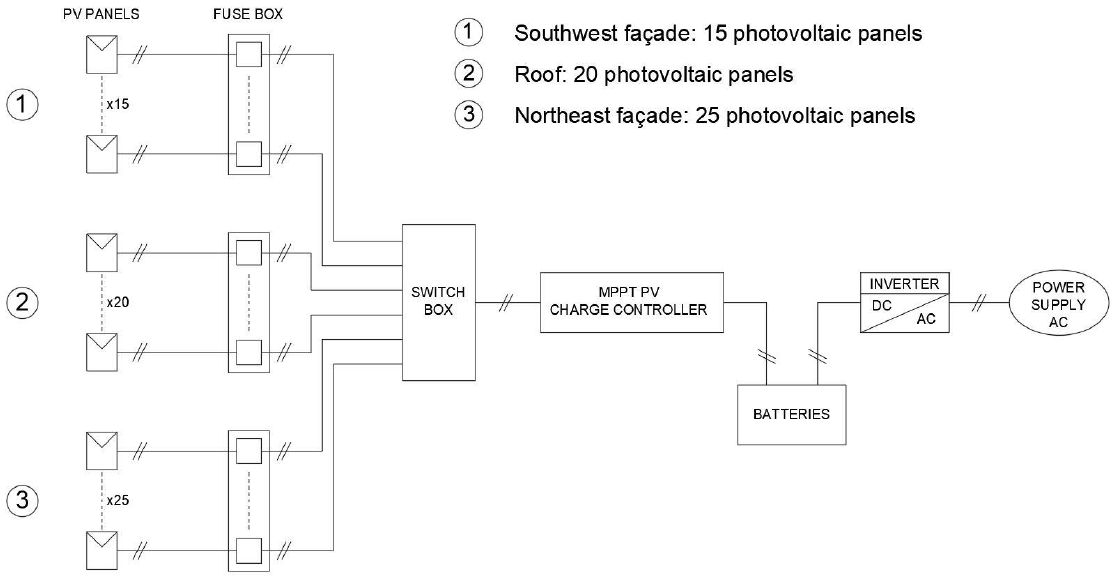
Figure 9. Connection diagram of the PV system and connected to batteries by regulator and inverter.